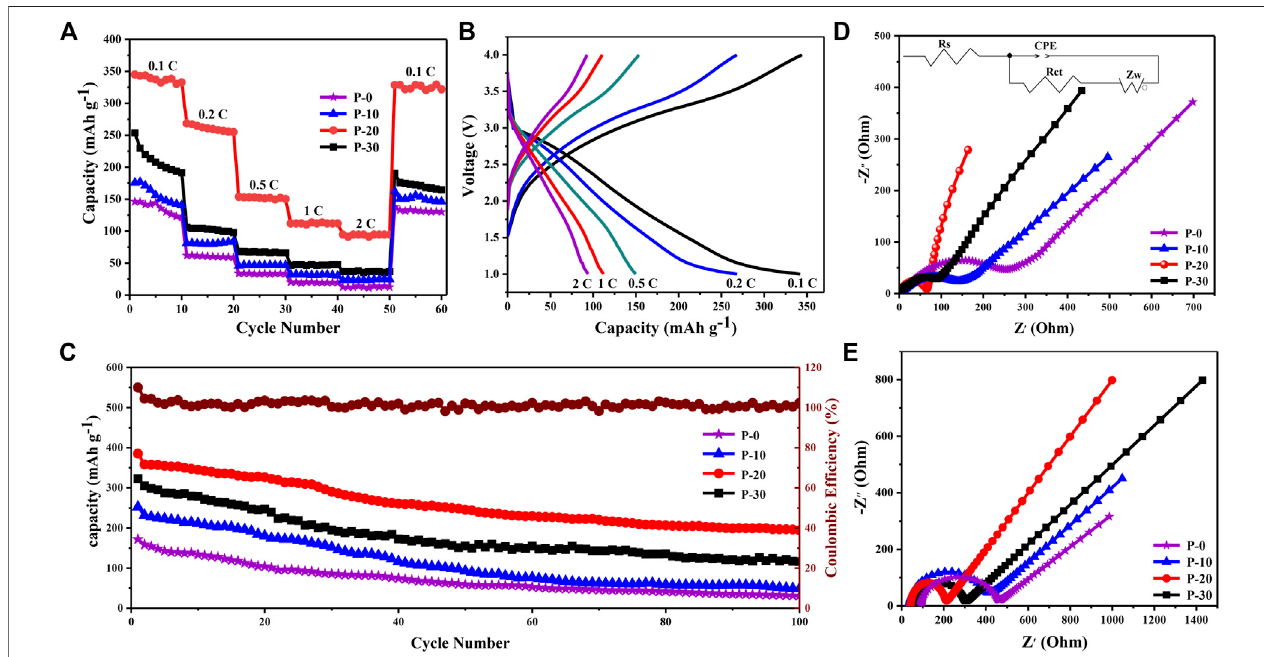
FIGURE 6 | (A) Rate properties of all electrodes between 0.1 and 2 C. (B) The initial charge/discharge pro fi les ofP-20 electrode between 0.1 and 2 C. (C) Cycling properties of all electrodes and the Coulombic ef fi ciency of P-20 electrode at 0.1 C between 1.0 and 4.0 V. (D) Nyquist plots of all electrodes before cycling, inset: the equivalent circuit model. (E) Nyquist plots of all electrodes after 100